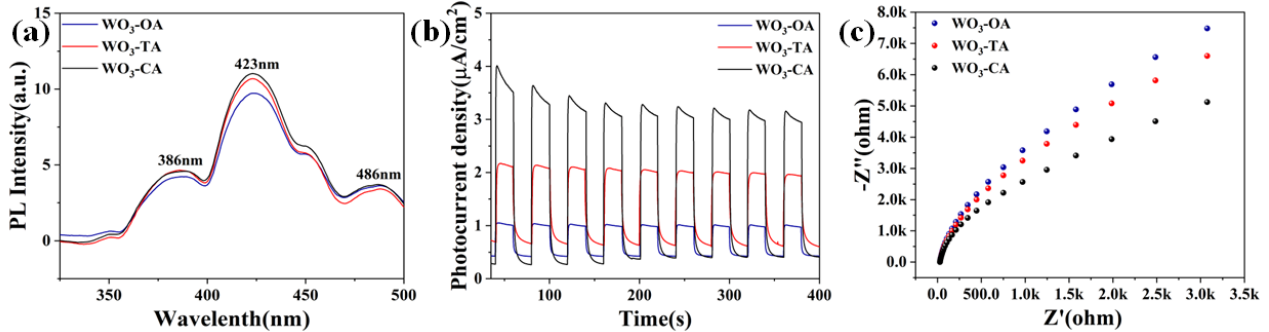
Figure 5. ( a ) The PL spectra of the different WO 3 samples. ( b , c ) Transient photocurrent responses and EIS Nyquist plots.